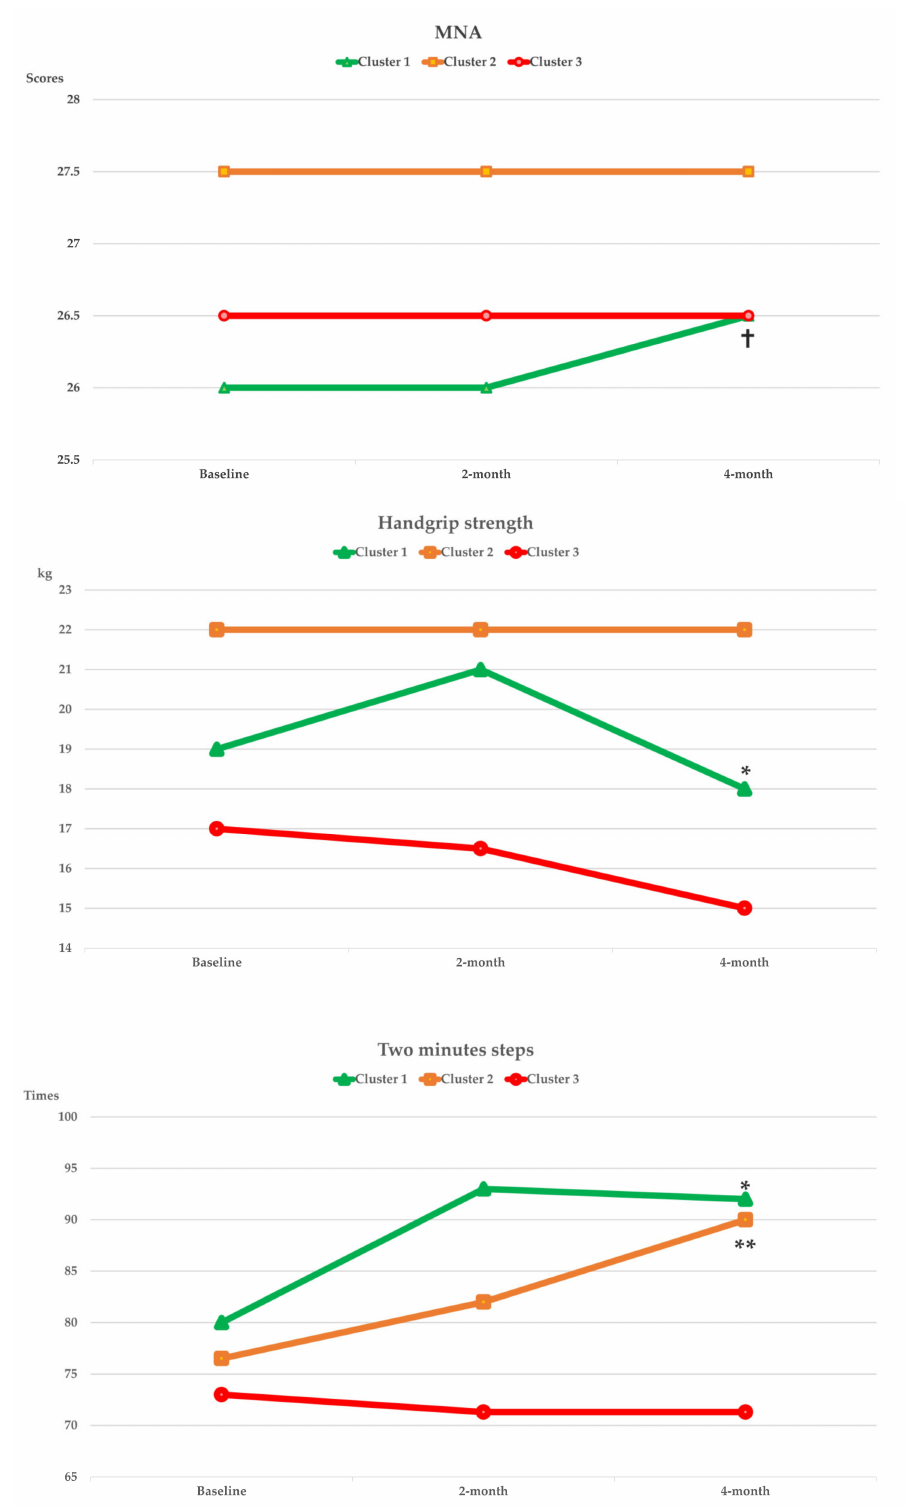
Figure 3. Curve chart for the within cluster comparison of median of intrinsic capacity in vitality captured by MNA, HGS, and TMS at two-month and four-month of intervention. * , ** Indicated significant different from baseline, compared by Wilcoxon Signed Rank test; * p < 0.05, ** p < 0.01. † Indicated significant different trend from baseline, compared by Friedman test. HGS, handgrip strength; MNA, Mini Nutritional Assessment; TMS, two minutes